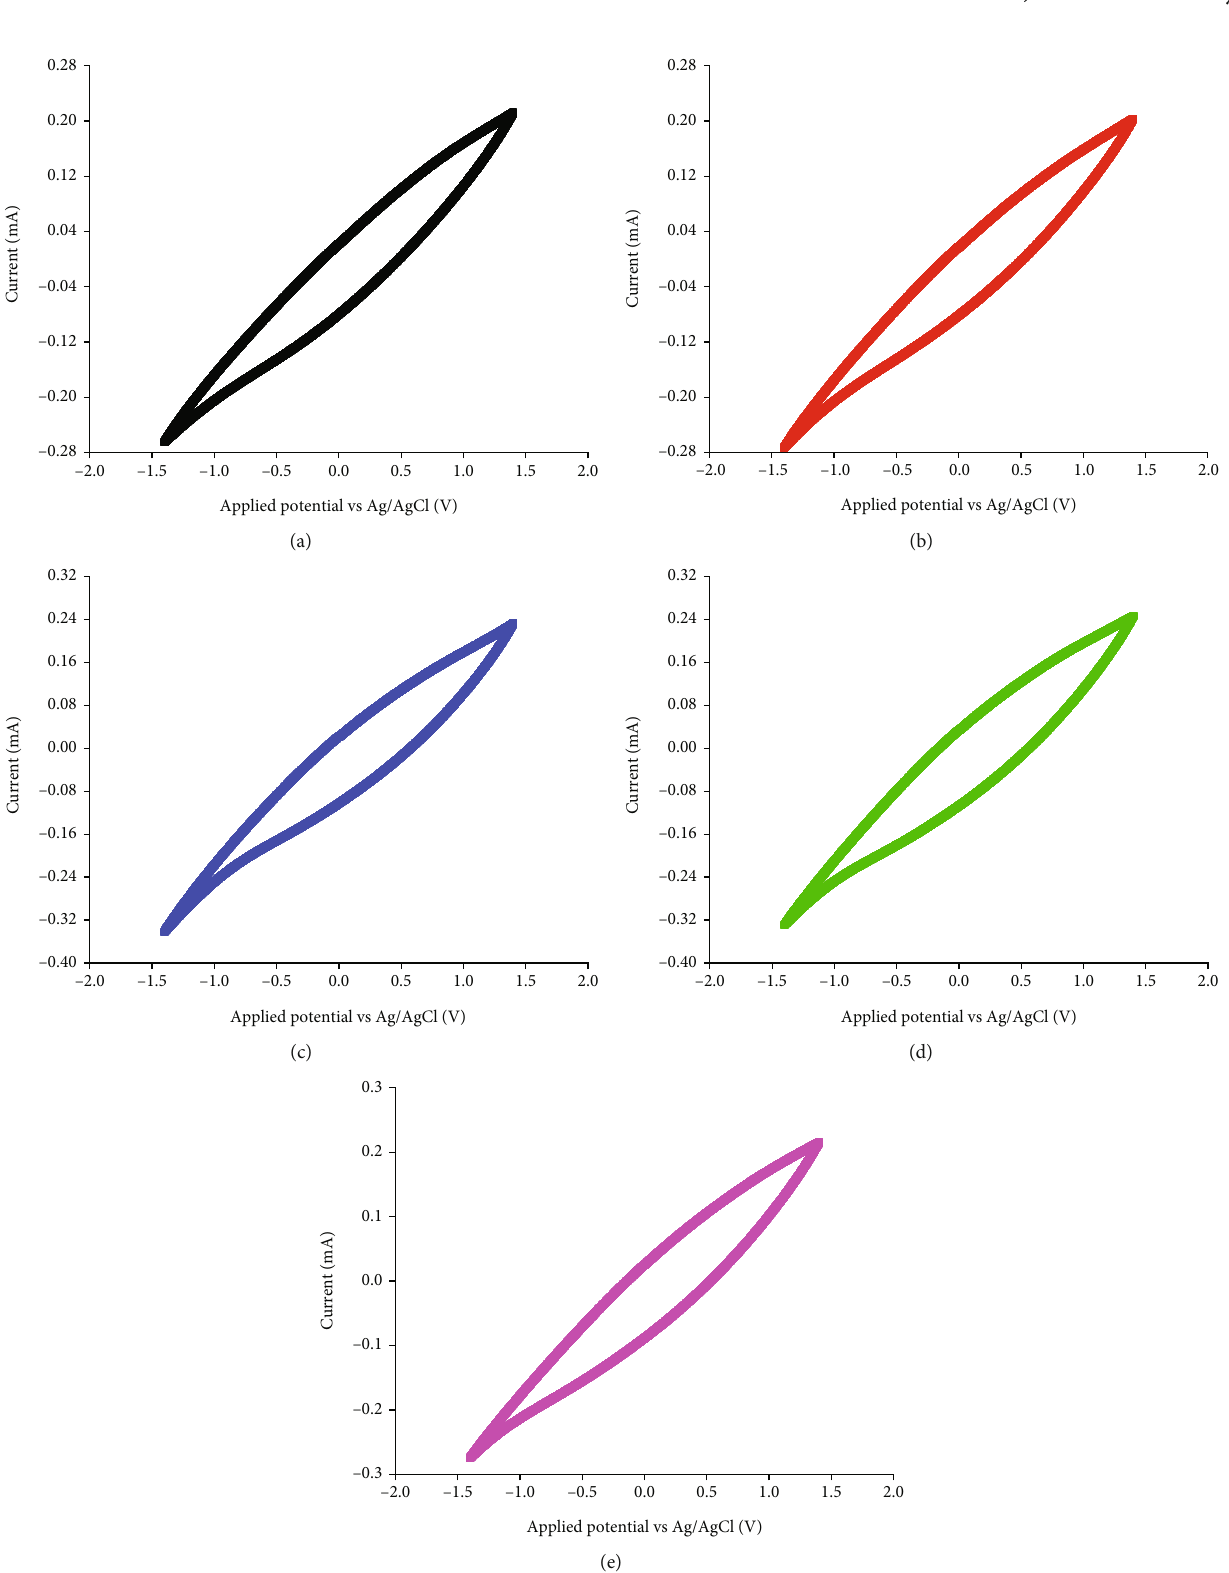
Figure 2: Cyclic voltammetry (CV) for each MFC without sludge (inoculum): (a) CV of MFC with acetate; (b) CV of MFC with sulfate; (c) CV of MFC with mineral medium only; (d) CV of MFC with Fe 2+ only; (e) CV of MFC with Fe 3+